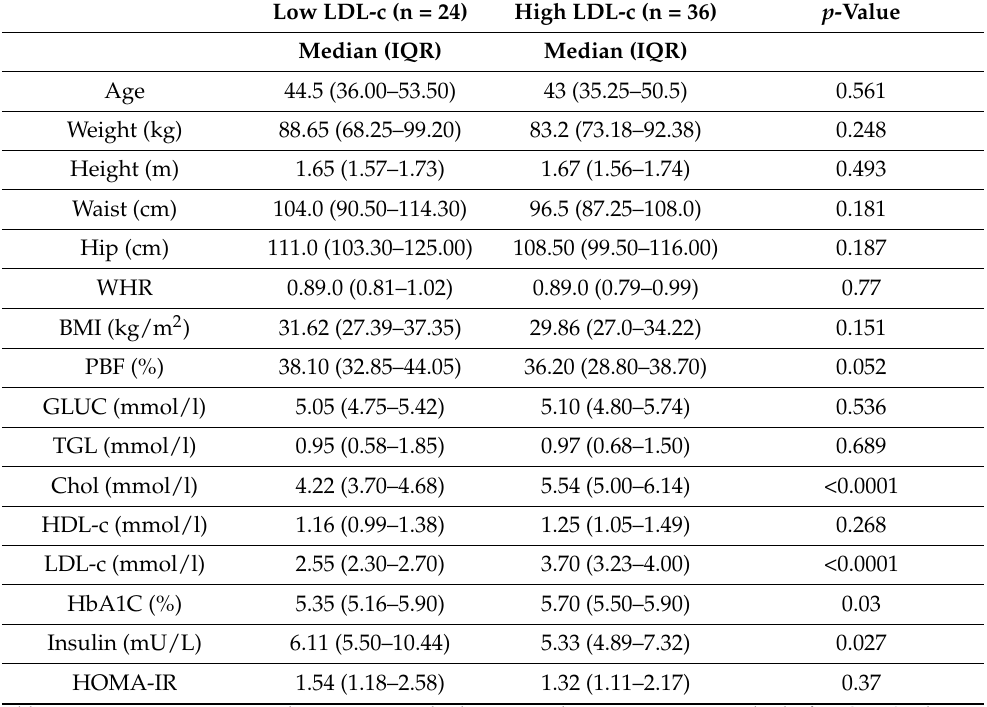
Table 1. Anthropometric, clinical and biochemical characteristics of the study